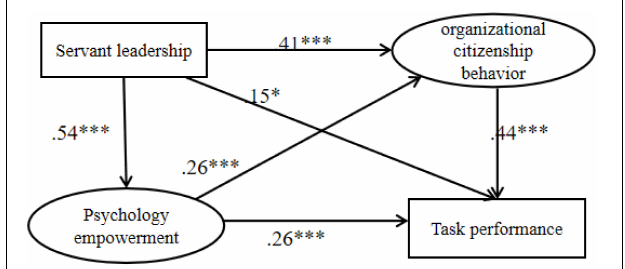
FIGURE 2 | The serial mediation model between servant leadership and task performance. * p < 0.05, and *** p < 0.001.